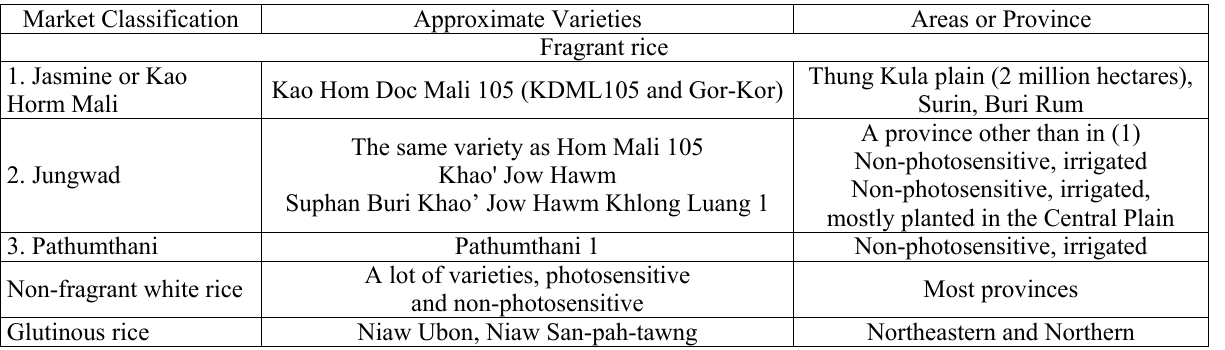
Table 6. Rice Varieties in